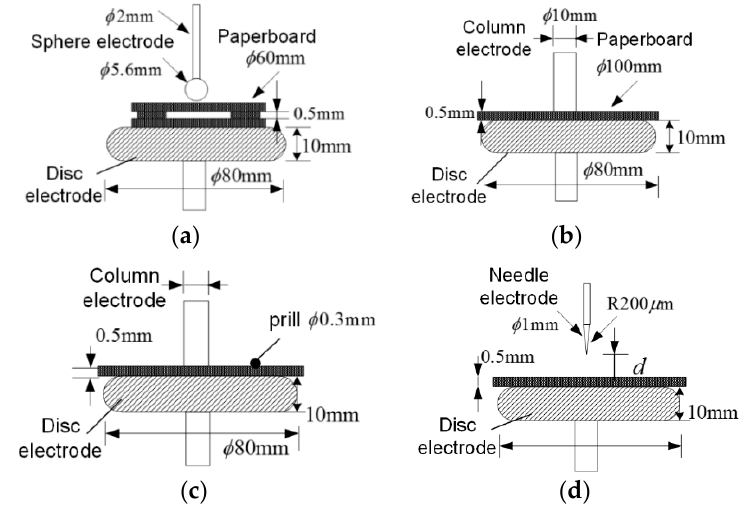
Figure 6. Sketch of typical insulation defect model: ( a ) Air gap discharge; ( b ) Surface discharge; ( c ) Floating discharge; and ( d ) Corona in oil.